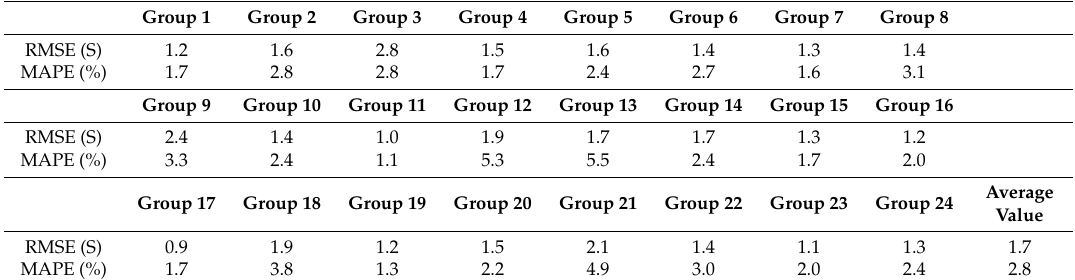
Table 6. Error evaluation during training phase for Sort